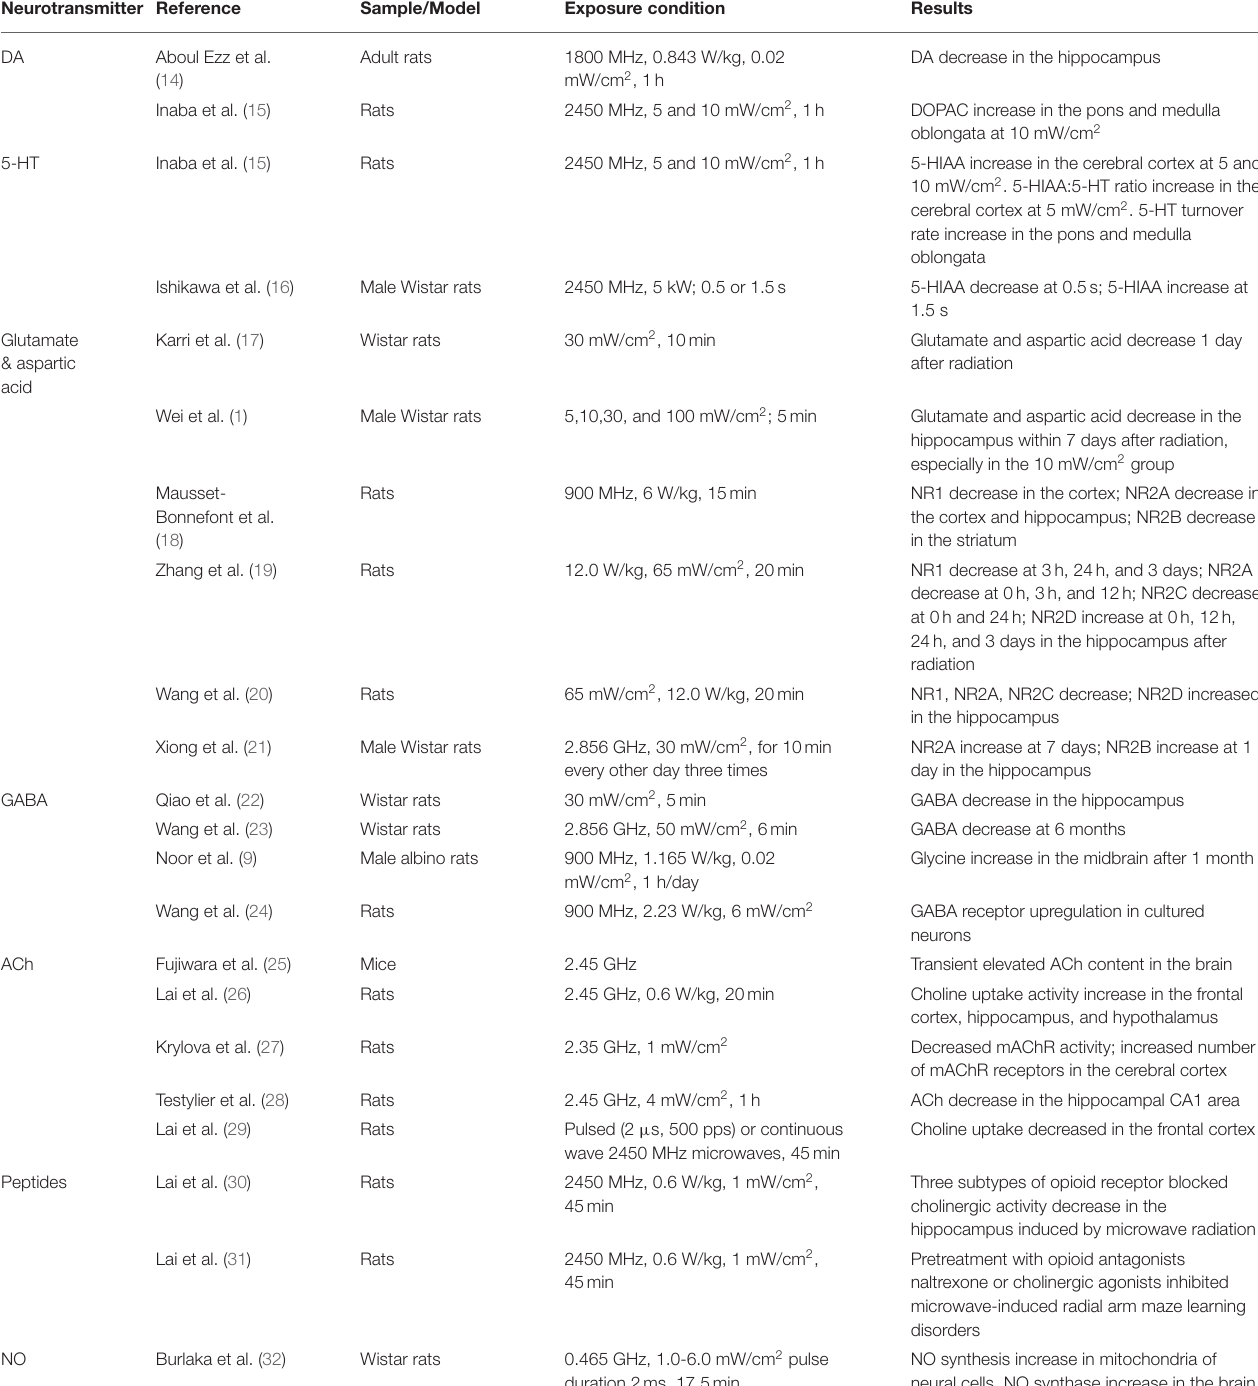
TABLE 1 | The influence of short-term EMR exposure on neurotransmitters in the brain. Neurotransmitter